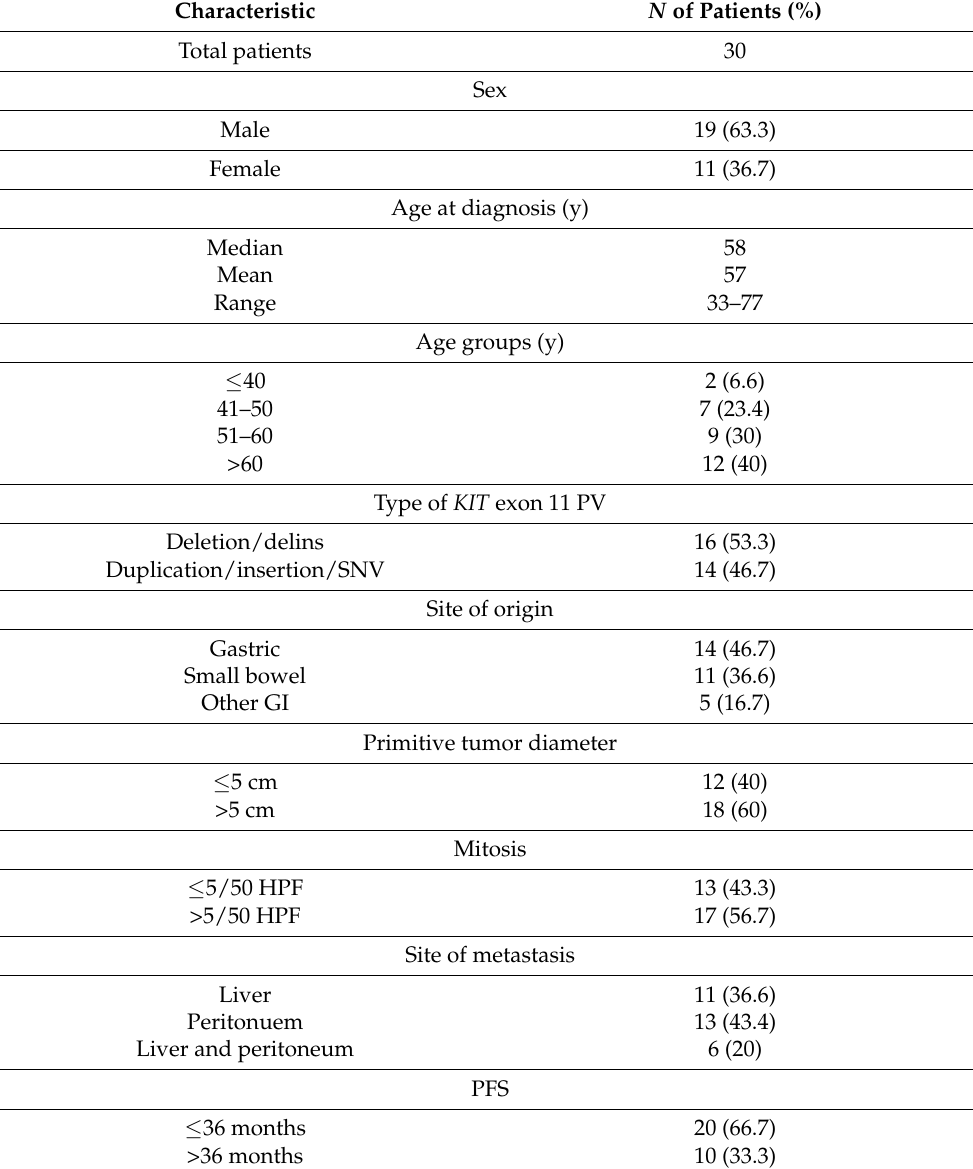
Table 1. Clinico-pathological characteristics of metastatic GIST